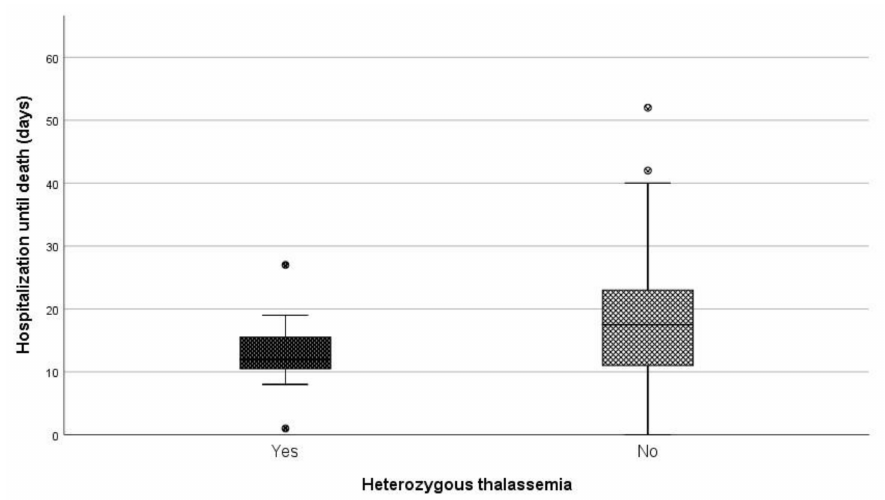
Figure 3. Days of hospitalization until death between carries and